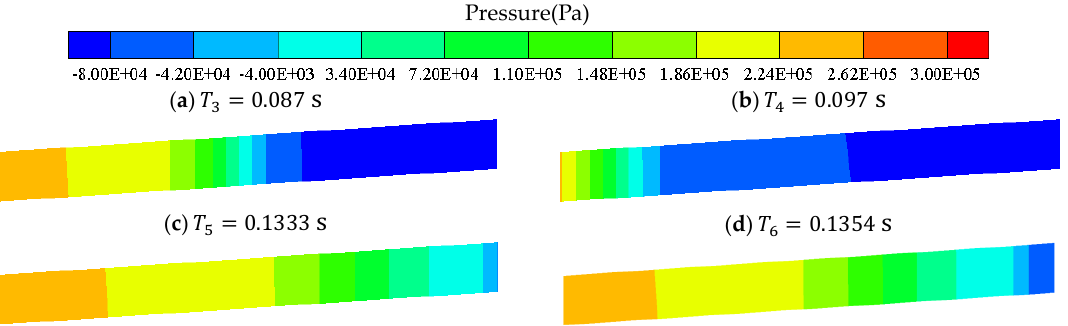
Figure 33. Evolution of vapor volume fraction on the axis plane of the pipeline in the cavity collapse stage.